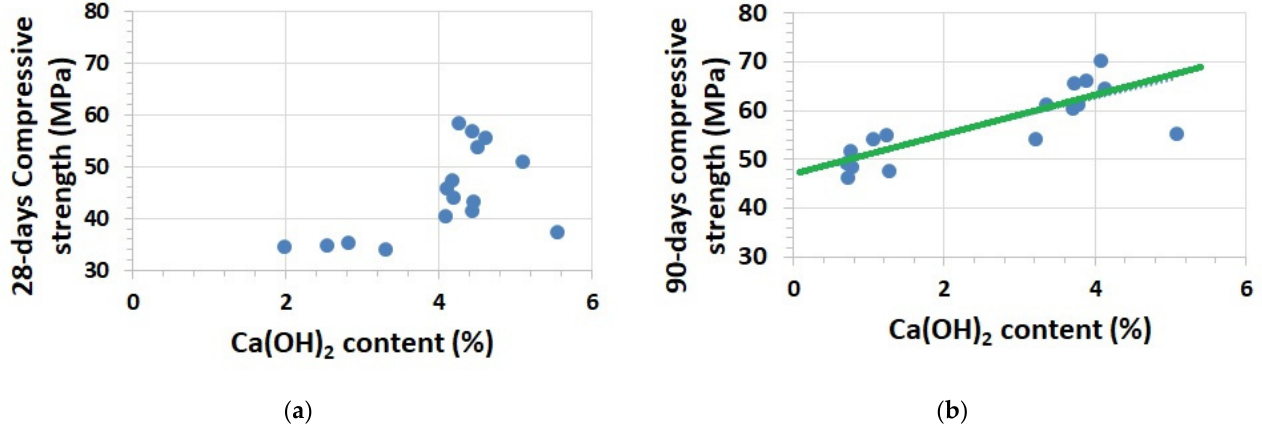
Figure 10. Calcium hydroxide content versus compressive strength at: ( a ) 28 days; ( b ) 90 days.